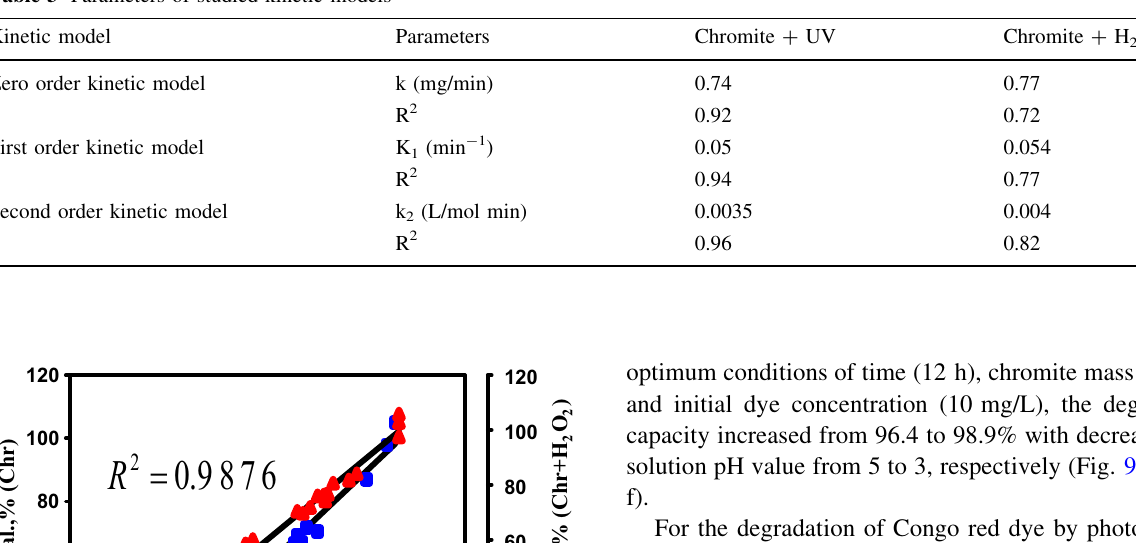
Table 3 Parameters of studied kinetic models